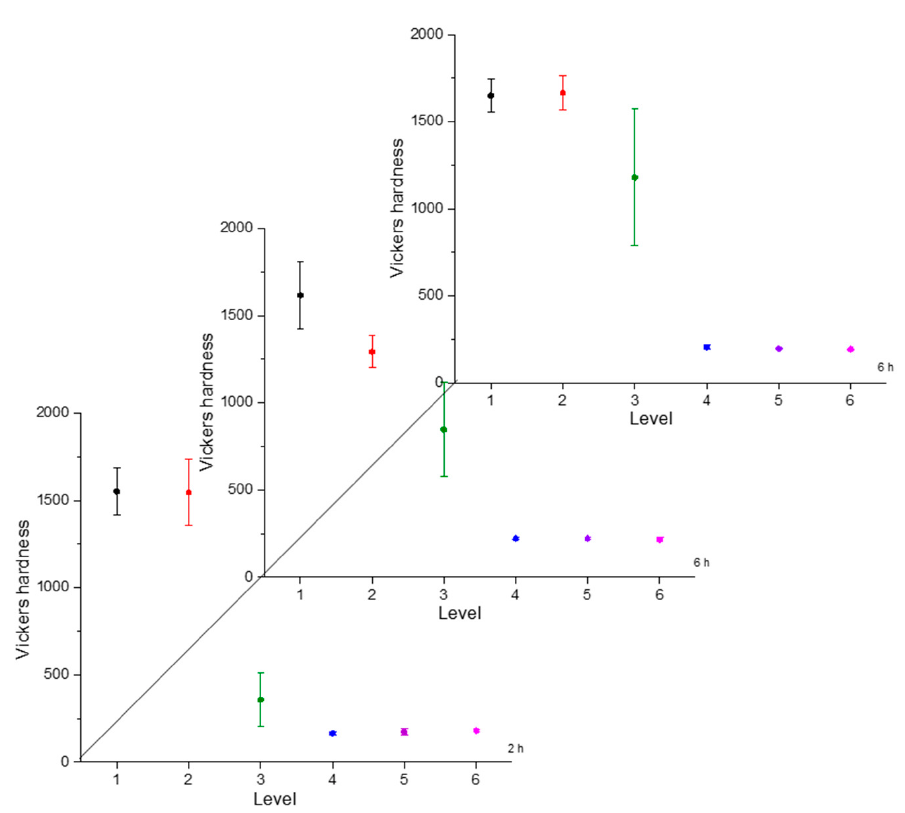
Figure 5. Microhardness evolution after boriding treatment at 900 °C.